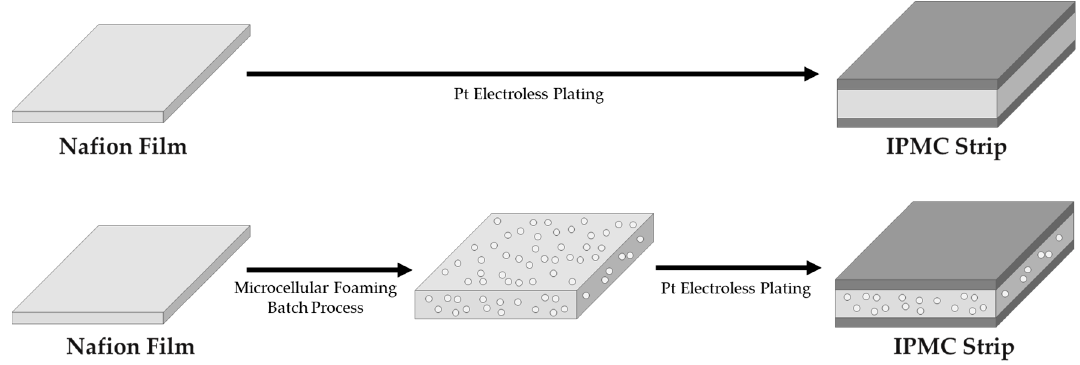
Figure 1. Ionic polymer–metal composite (IPMC) strip prepared by microcellular foaming process of Nafion, which is the polymer electrolyte of this study.